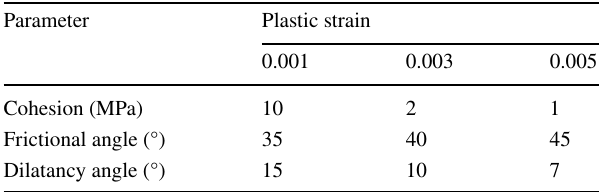
Fig. 16 Final failure mode of circular cavern with a nearby structural plane before and after being subjected to external dynamic disturbances in vertical direction Table 2 Material properties changed based on different plastic strains (Feng et al. 2019b)